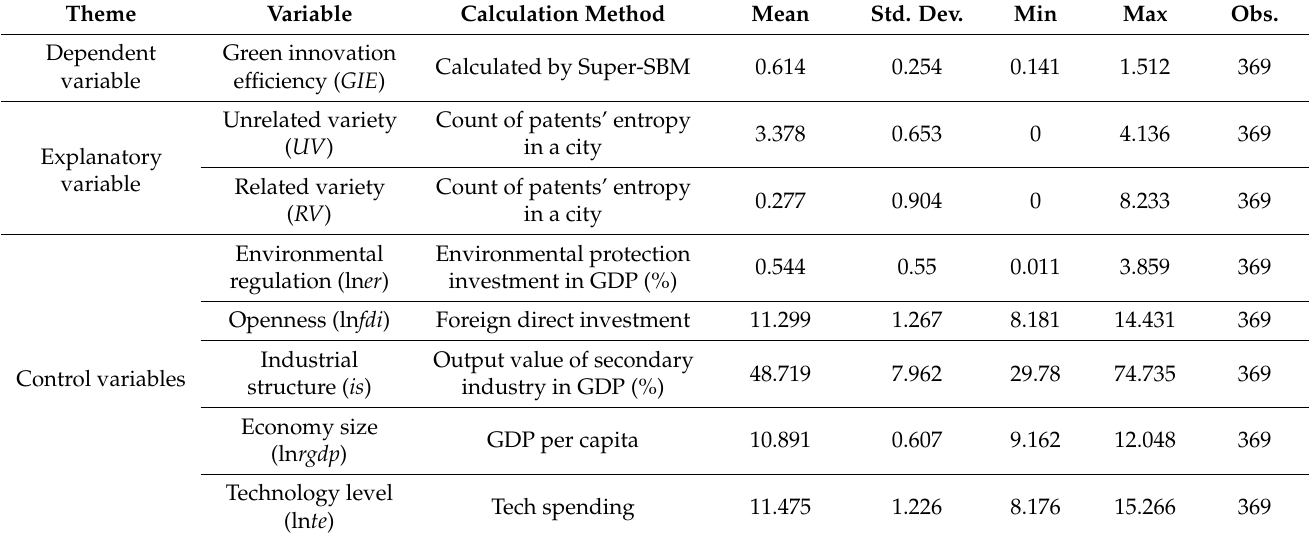
Table 2. Descriptive statistics of